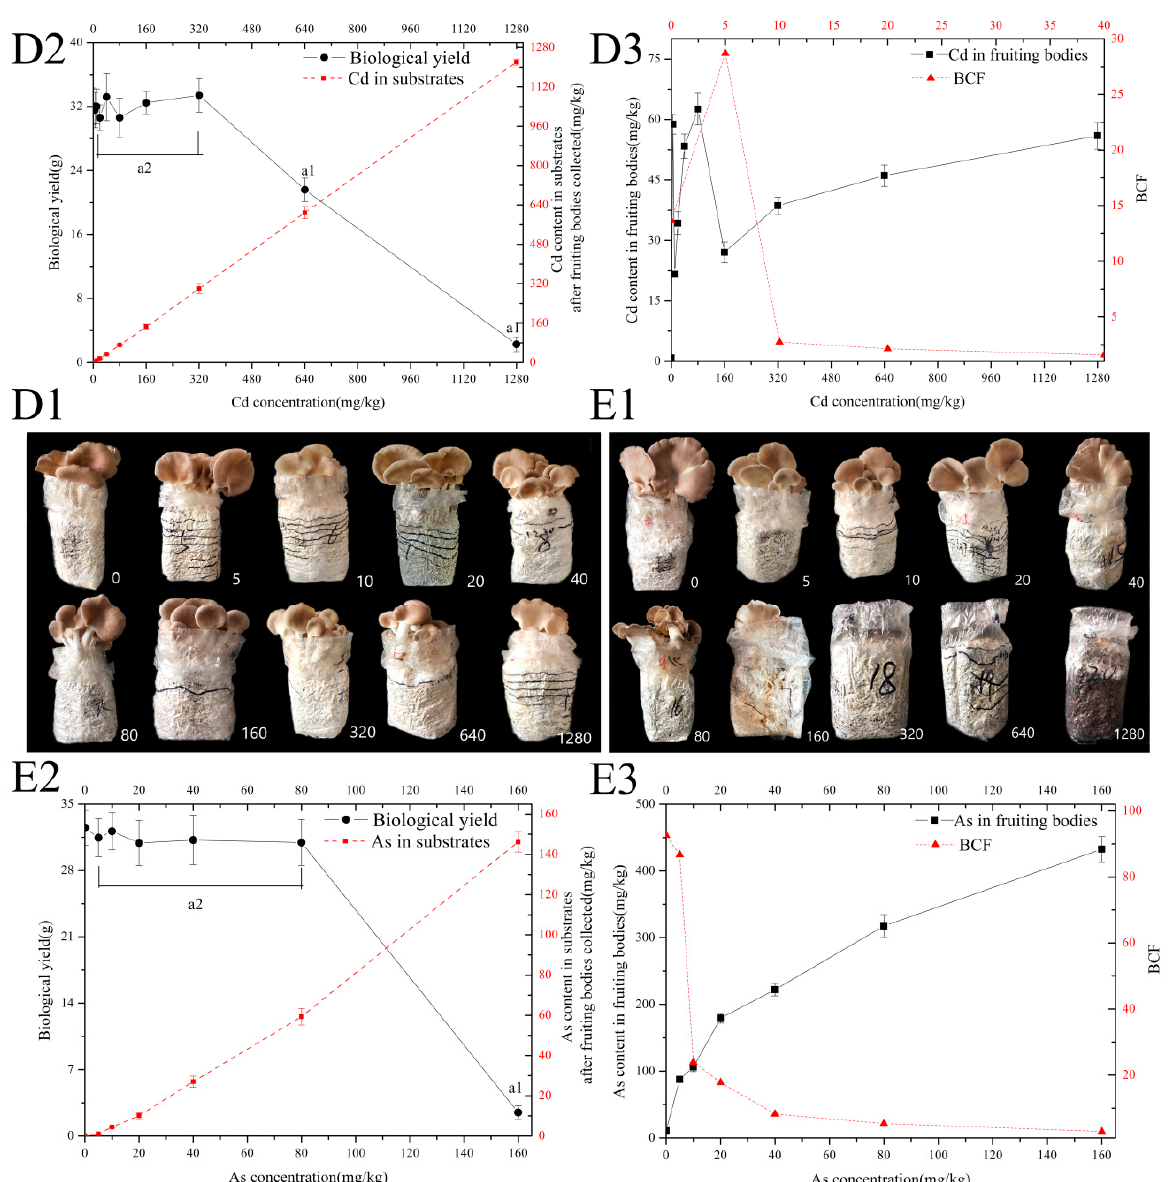
Figure 3. Effect of Cd and As stress on biological yield and Cd/As content of the fruiting bodies in P. pulmonarius MT (x ± s, n = 4). ( D1 ) fruiting bodies cultivated under Cd stress; ( D2 ) biological yield of fruiting bodies and Cd content in substrate; ( D3 ) Cd content in fruiting bodies and bio-enrichment coefficients (BCF); ( E1 ) fruiting bodies cultivated under As stress; ( E2 ) biological yield of fruiting bodies and As content in substrate; ( E3 ) As content in fruiting bodies and BCF; a1: p < 0.05; a2: p >